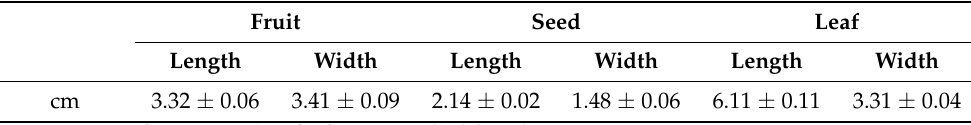
Table 2. Data on morphological descriptive traits related to fruit, seed, and